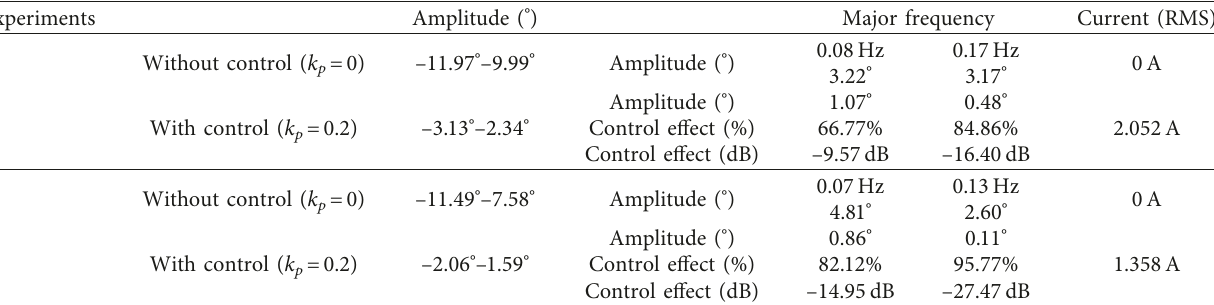
Figure 12: Vibration control experiments: (a) Experiment I ; (b) Experiment II . Table 6: Vibration control effect in Experiments I and II